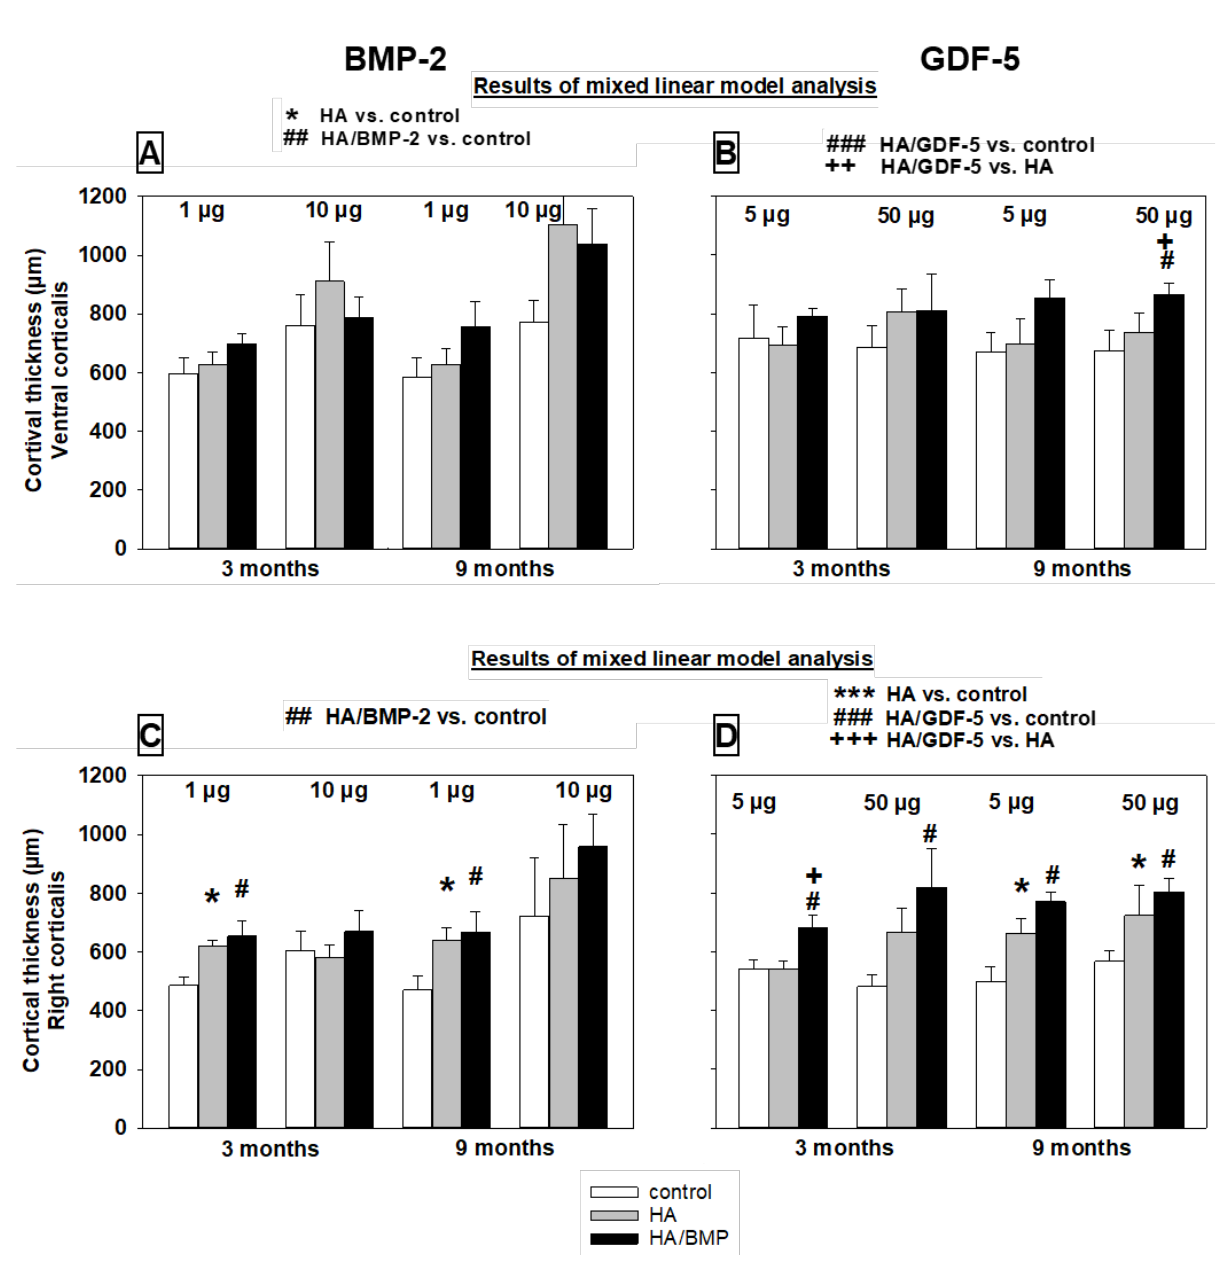
Figure 9. Increase of cortical thickness ( µ m) in paraffin sections of lumbar vertebral bodies (L3 = control, L4 = HA/BMP; L5 = HA) of all investigated groups in the ventral corticalis close to the tip of the injection channel ( A , B ) and the right corticalis ( C , D ). Results of the mixed linear model analysis (compare with Table 2 and Table S2); *** p < 0.001, * p ≤ 0.05 for HA compared to non-injected control; ### p < 0.001, ## p ≤ 0.01, # p ≤ 0.05 for HA/BMP compared to non-injected control; and +++ p < 0.001, ++ p ≤ 0.01, + p ≤ 0.05 for HA/BMP compared to HA. Please note: The linear mixed effects model was used to analyze global effects and overall interactions of the main effects treatment (group), time point (time), BMP dose (dose), and distance from the injection channel (area); subsequently, the non-parametric multigroup Kruskal-Wallis and two-sided Wilcoxon tests were applied for the comparison of paired samples within one group, and the multigroup Friedman and two-sided Mann-Whitney U-tests for statistical evaluation of differences between groups with the above-mentioned significance levels.